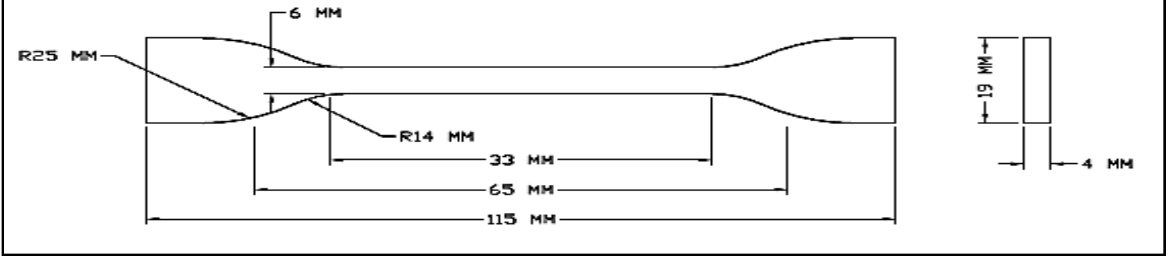
Fig. 06: Specimen Dimensions